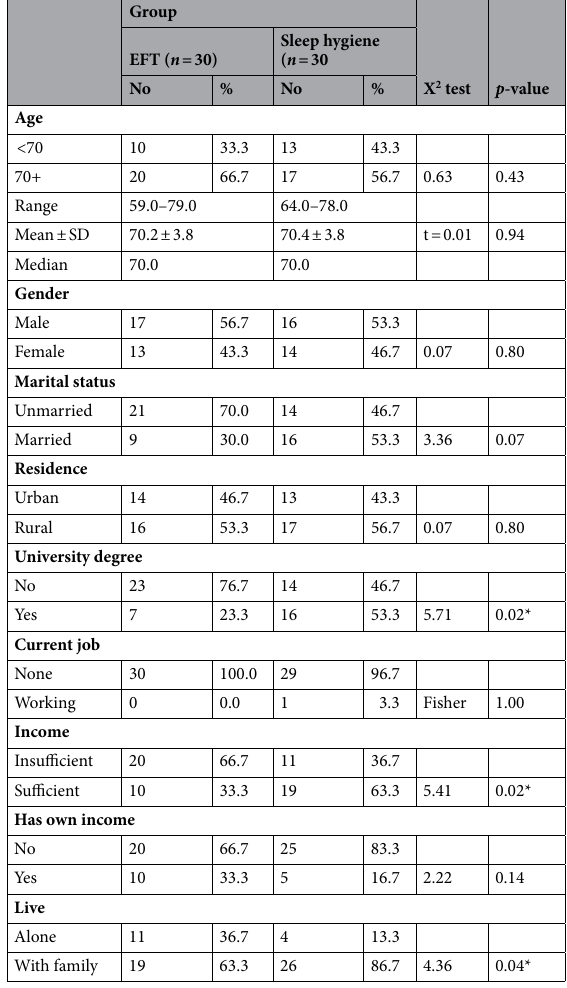
Table 1. Socio-demographic characteristics of elderly patients in the two study groups. (*) Statistically significant at p <